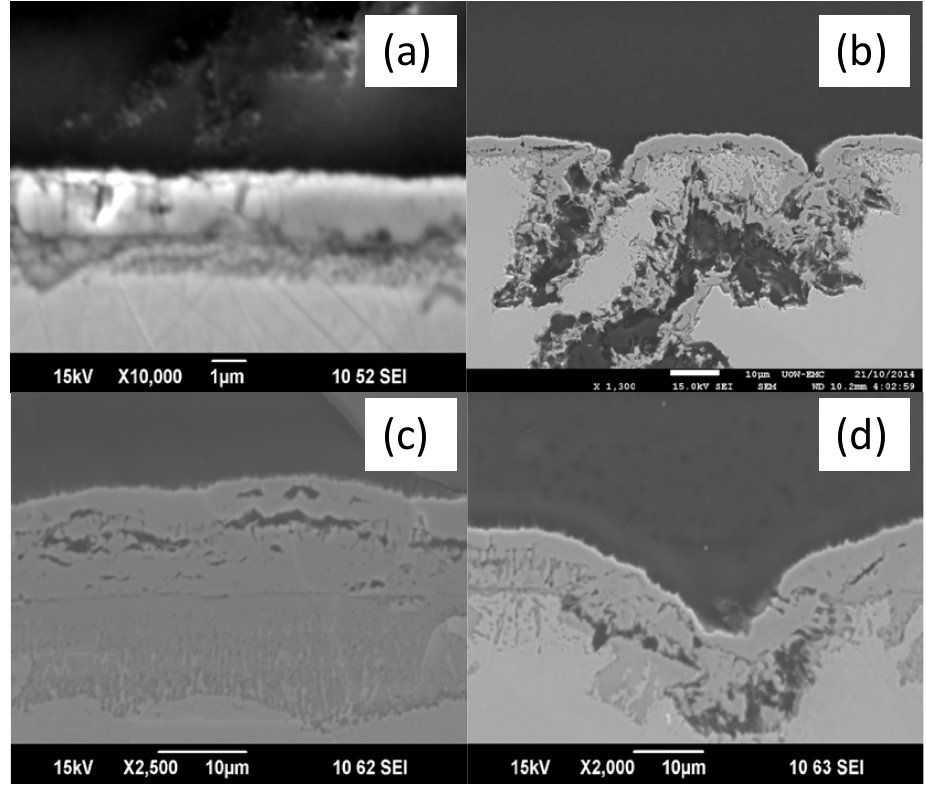
Figure 7. SEM images of the IC roll cross section oxidized at 700 °C: ( a ) the matrix regions and ( b ) the graphite areas in dry air, and ( c ) the matrix regions and ( d ) the graphite areas in humid air.